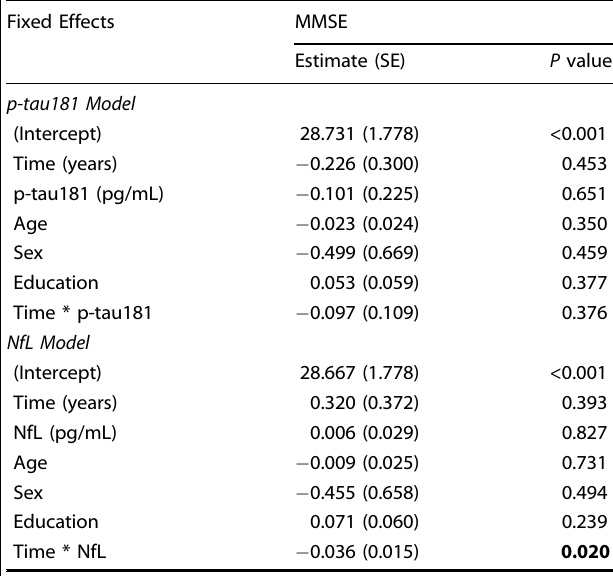
p-tau181 phosphorylated tau 181, NfL neuro fi lament light chain, MMSE Mini Mental State Examination, SE standard error, pg/mL picogram per millilitre. Bold values denote statistical signi fi cance at the P <0.05